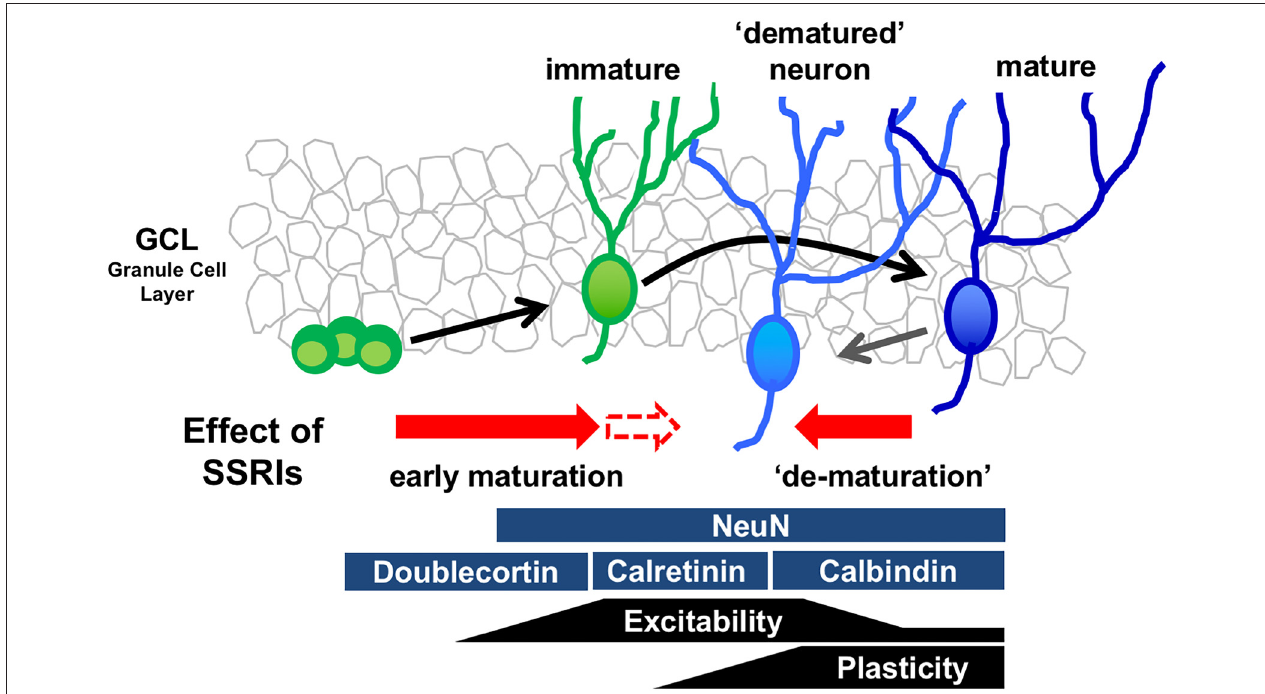
FIGURE 1 | Model of bidirectional effects of chronic serotonin (5-HT) reuptake inhibitors (SSRIs) exposure on the regulation of the state of maturation in the granule cells (GCs). Developmental stages of GCs in the dentate gyrus (DG) can be identified by stage marker expression and neural function. Chronic SSRI administration may have bidirectional effects on differentiating immature neurons and mature neurons, depending on the state of differentiation and